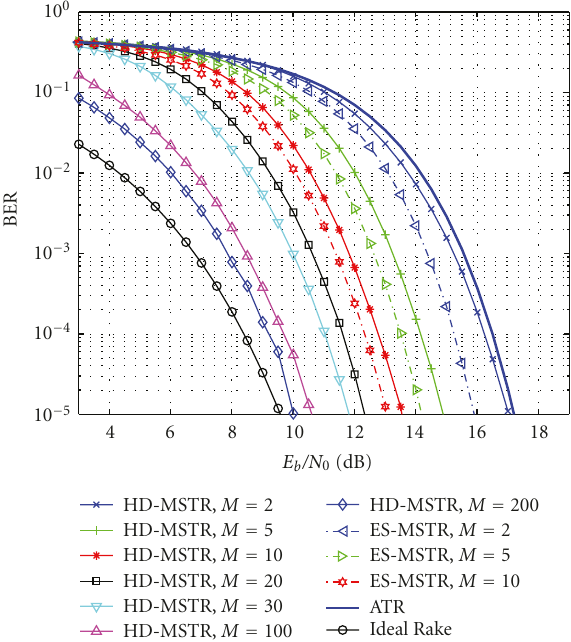
Figure 1: BER of HD-MSTR for di ff erent M , K = 200, N f = 20, N = 10